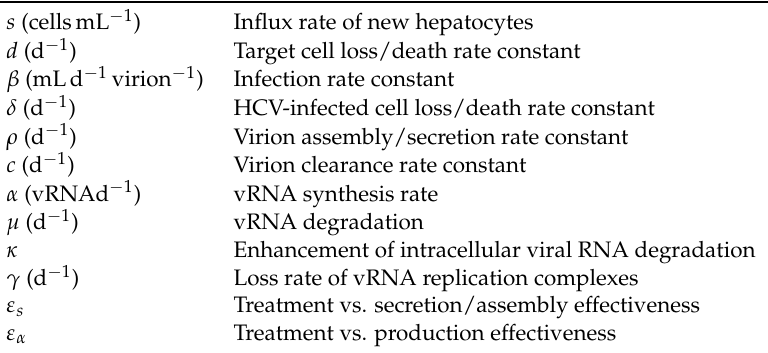
Table 1. The 12 parameters of the